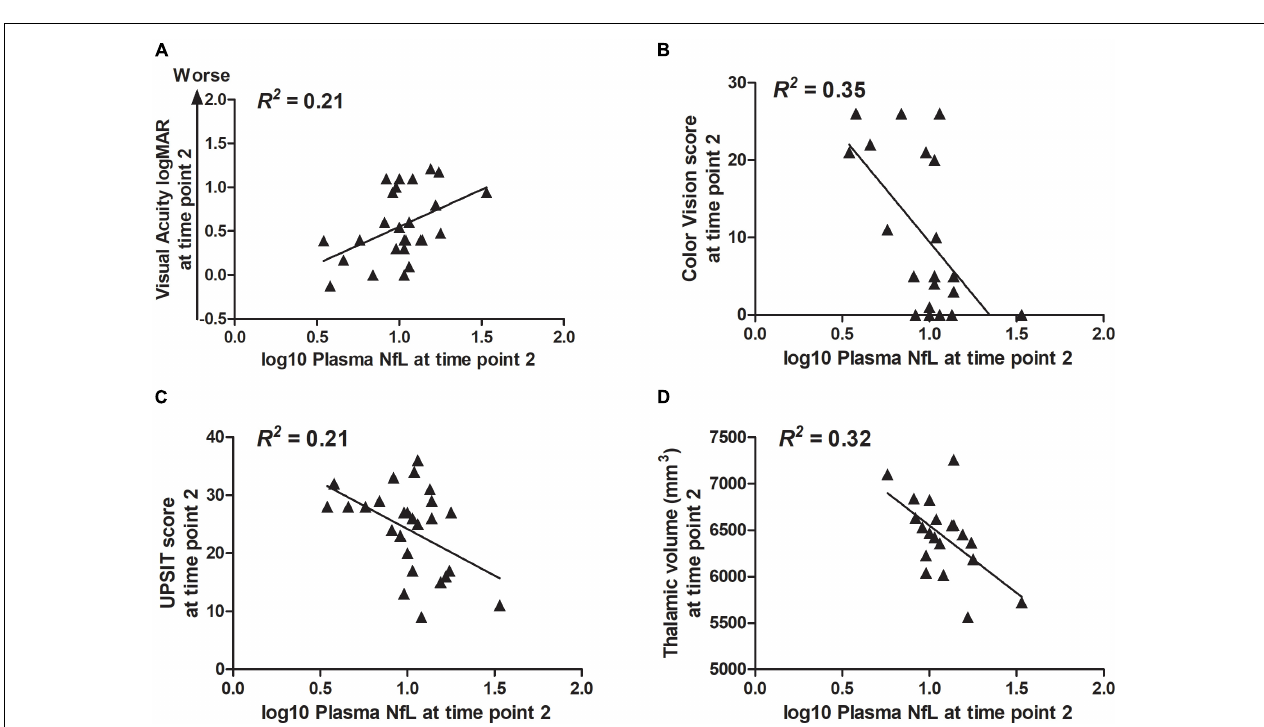
FIGURE 4 | Within the Wolfram group, higher log10 plasma NfL levels at time point 2 related to (A–D) worse visual acuity and color vision, less accurate smell identification, and smaller thalamic volume at time point 2.